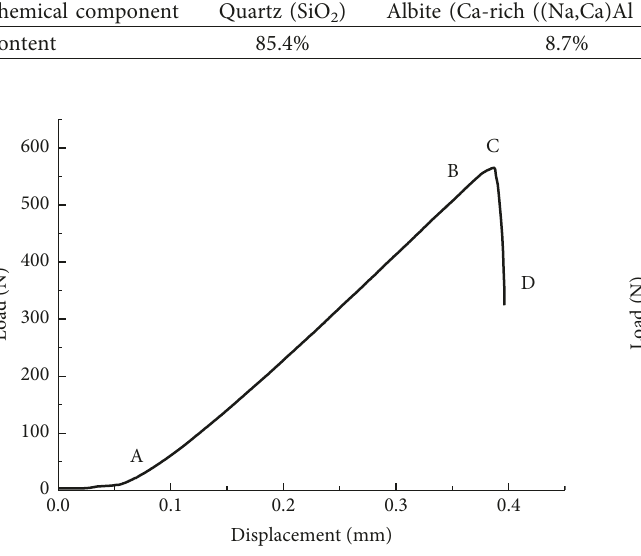
Figure 3: Typical load-displacement curve of sandstone.